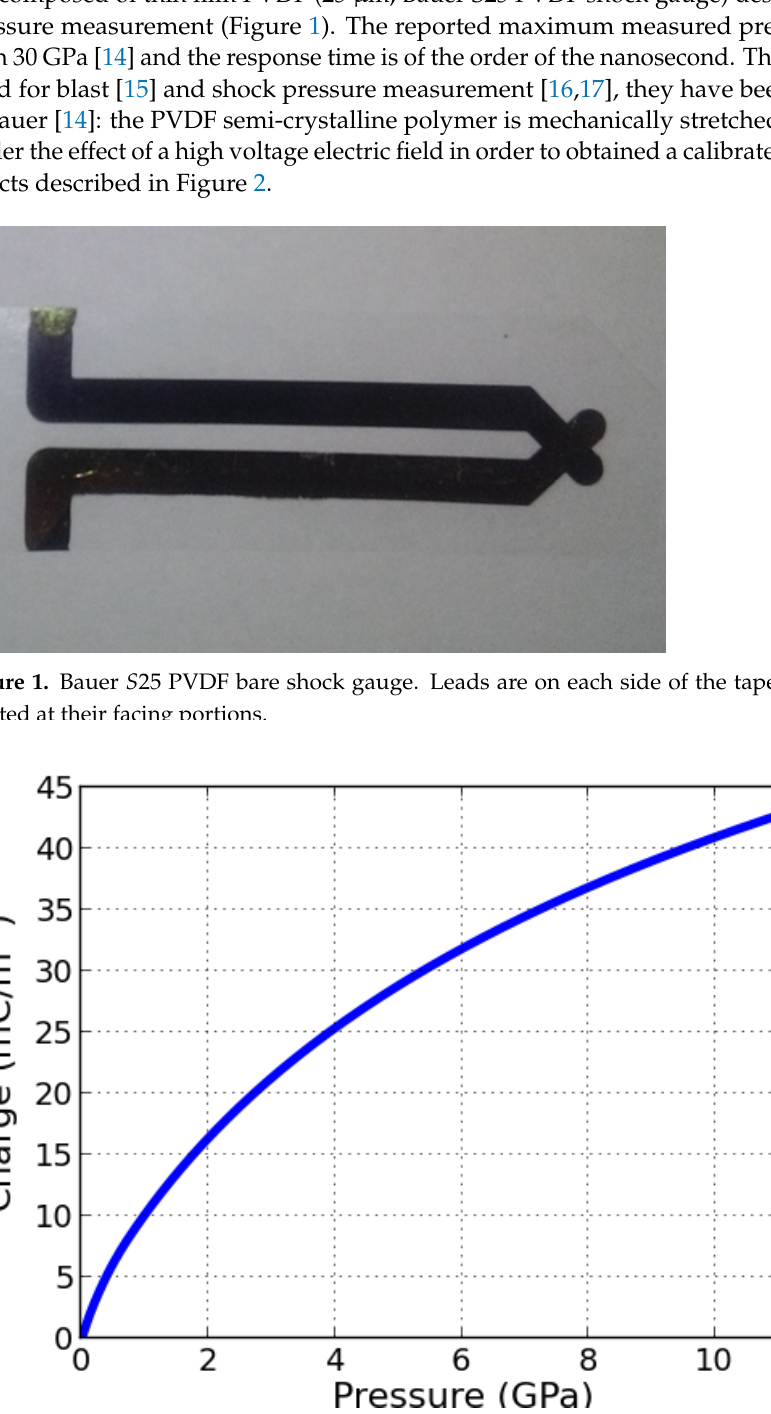
Figure 2. Calibration of electrical charges per unit of area produced by PVDF versus loading pressure under mono-dimensional shock pressure (inspired from